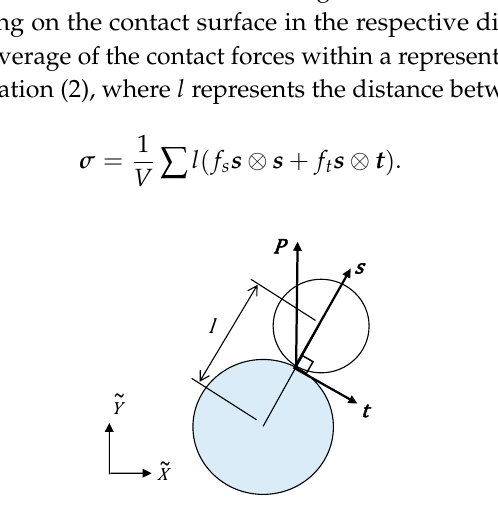
Figure 1. Concept of multiple shear mechanism: normal vector 𝒔 , tangential vector 𝒕 , and contact force 𝑷 .